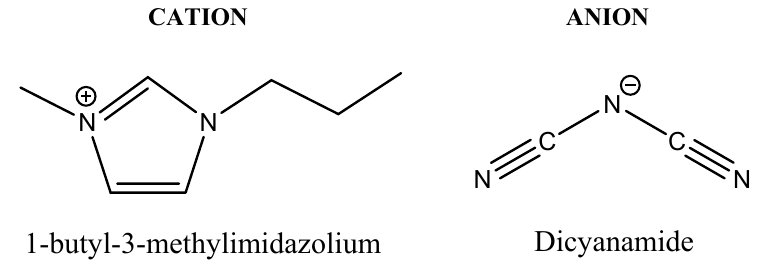
Figure 2. Structure of ionic liquid used in this